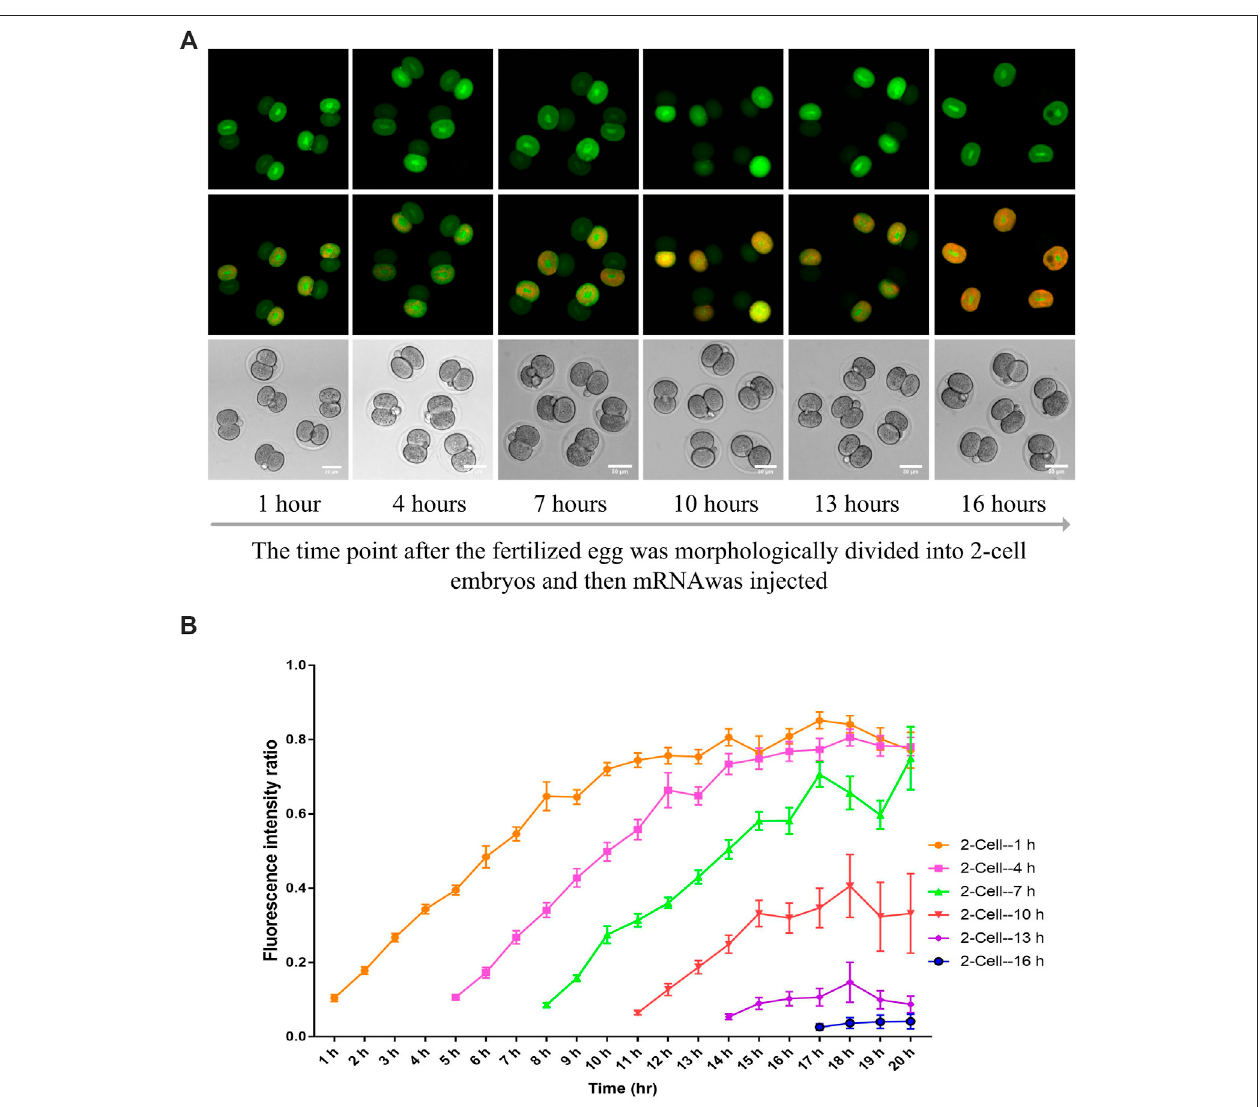
FIGURE2| TheanalysisofGFPtransportdynamicsbetweenthetwodaughtercellsin2-cellmouseembryos. (A) Representativeimagesof2-cellembryosinjected with mRNA at different times and imaged 4 h later. (B) The ratio of GFP intensity between the GFP mRNA non-injected daughter cell and the GFP mRNA-injected daughter cell. One daughter cell from the 2-cell embryo at different time points was microinjected with GFP-expressing mRNA and imaged every hour later. The time points include 1, 4, 7, 10, 13 and 16 h after the fertilized egg morphologically divided into two cells. Each experiment was replicated three times, and n (cid:1) 13 – 15 for each group. The data are expressed as mean ±